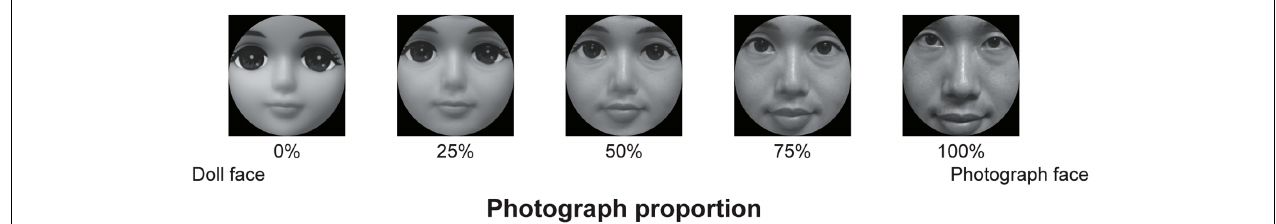
FIGURE 4 | Stimuli used in Experiment 2.